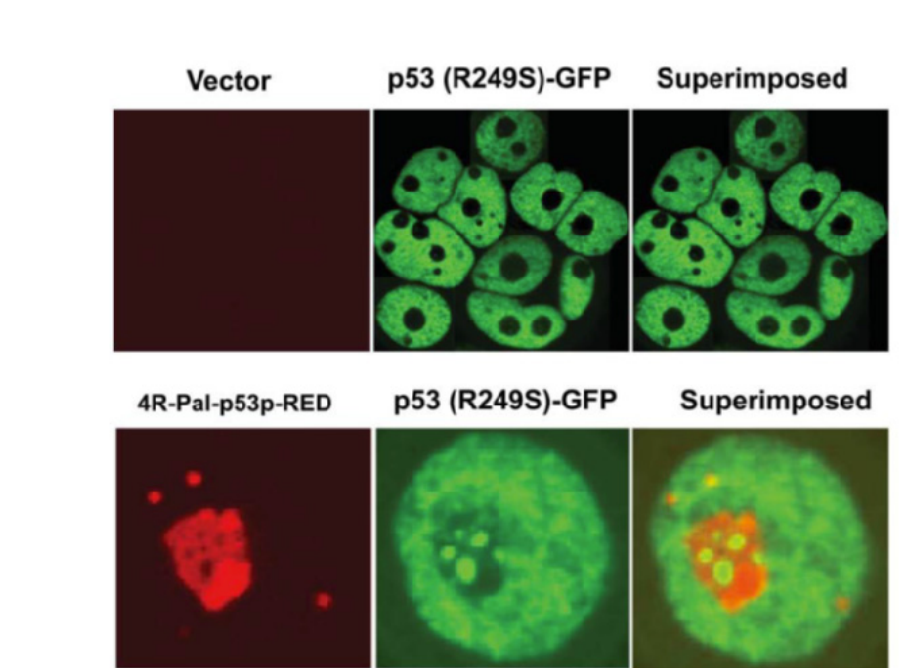
Figure 4. ( A ) Subcellular localization of endogenous 4R-Pal-p53p and p53. MDA-MB468 cells (mutant p53, R273H) were transiently transfected with Ad-4R-Pal-p53p-GFP. Twenty-four hrs after transfection, cells were fixed and labelled with a monoclonal antibody to N-terminal p53 (anti-p53 DO1 epitope aa 18–30) followed by TR labeled secondary antibody (as described in Materials and Methods). To visualize the nuclei, cells were stained with DAPI. Images were taken using an epi-fluorescent microscope. The superimposed panels were merged images of the respective images and showed that p53 localized in the nuclear and not in the nucleolus whereas 4R-Pal-p543p localize in the nuclear and nucleolus. ( B ) 4R-Pal-p53p translocates mutant p53 into the nucleolus. H1299